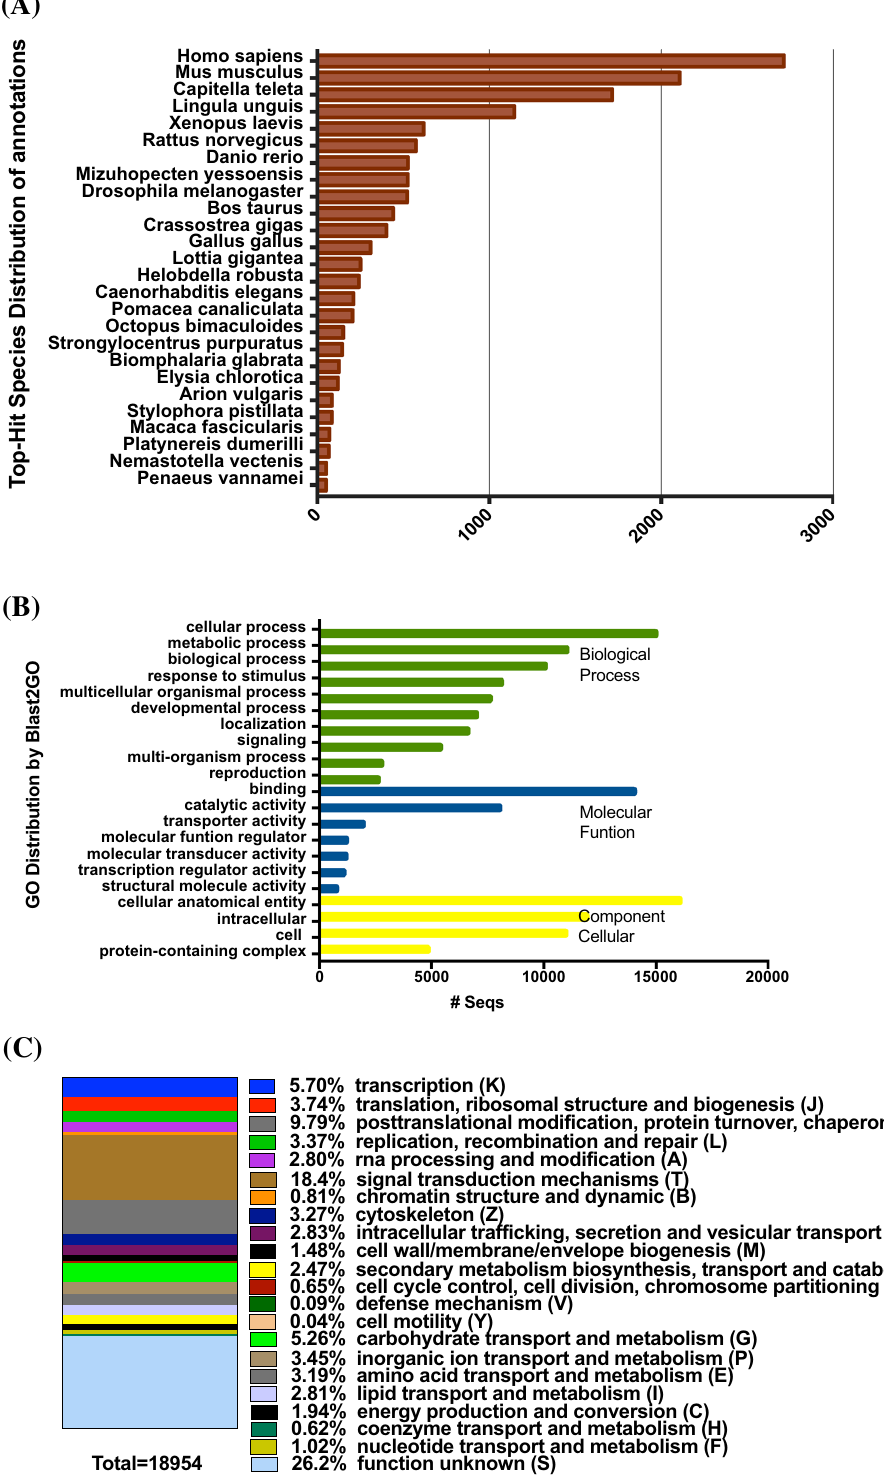
Figure 1. Characteristics of genes. ( A ) Top ten species distribution. ( B ) Functional annotation based on Gene Ontology (GO) categorization. ( C ) COG categories distribution of EggNOG